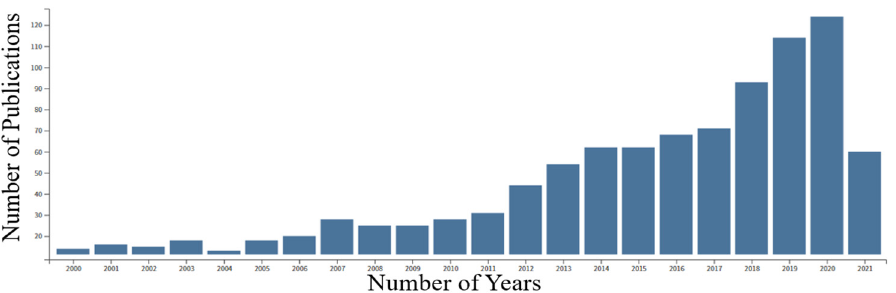
Figure 1. A bar graph shows journal articles published between 2000 and 2021 on “self-lubricating materials” from the Web of Science.